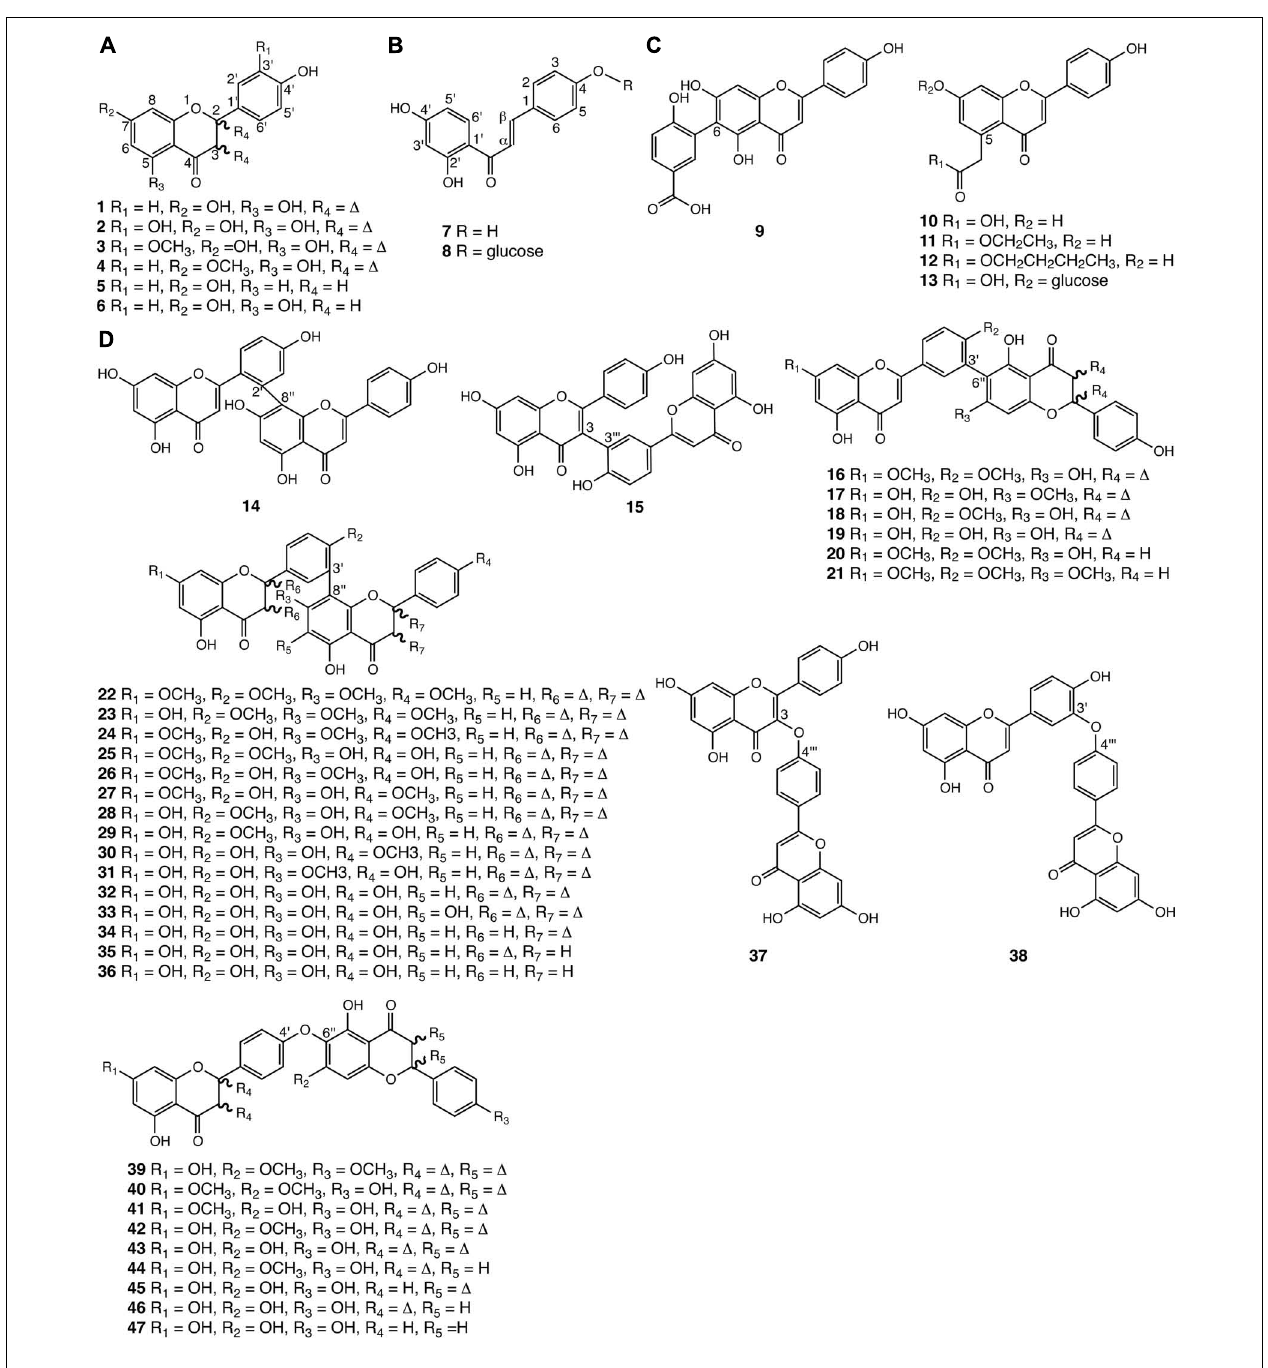
FIGURE 3 | Flavonoids identified from Selaginella . (A) Common flavones and flavanones: apigenin ( 1 ), luteolin ( 2 ), chrysoeriol ( 3 ), genkwanin ( 4 ), 4 (cid:2) ,7-dihydroxyflavanone ( 5 ), 4 (cid:2) ,5,7-trihydroxyflavanone ( 6 ). (B) Chalcones: 6 (cid:2) -deoxychalcone ( 7 ), 6 (cid:2) -deoxychalcone, 4- O - β -glucoside ( 8 ). (C) Flavones with unusual ring substitutions: 6-(2 (cid:2)(cid:2) -hydroxy-5 (cid:2)(cid:2) -carboxyphenyl)-apigenin ( 9 ), 5-carboxymethyl-4 (cid:2) ,7-dihydroxyflavone ( 10 ), 5-carboxymethyl-4 (cid:2) ,7-dihydroxy flavone ethyl ester ( 11 ), 5-carboxymethyl-4 (cid:2) ,7-dihydroxyflavone butyl ester ( 12 ), 5-carboxymethyl-4 (cid:2) ,7-dihydroxyflavone-7- O - β - D -glucopyranoside ( 13 ). (D) Biflavonoids: 2 (cid:2) ,8 (cid:2)(cid:2) -biapigenin ( 14 ), taiwaniaflavone ( 15 ), 7,4 (cid:2) -di- O -methylrobus taflavone ( 16 ), 7 (cid:2)(cid:2) - O -methylrobustaflavone ( 17 ), 4 (cid:2) - O -methylrobustaflavone ( 18 ), robustaflavone ( 19 ), 7,4 (cid:2) -di- O -methyl-2 (cid:2)(cid:2) ,3 (cid:2)(cid:2) -dihydrorobustaflavone ( 20 ),